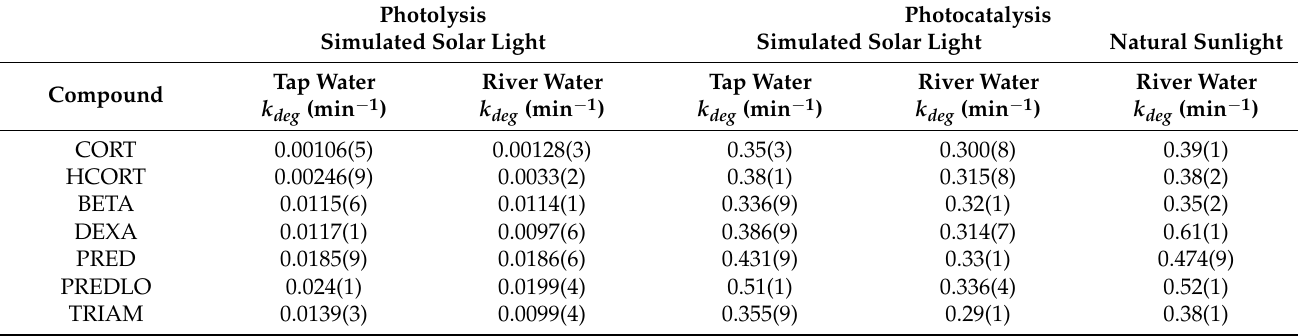
Table 2. Observed GCs degradation constants ( k deg ) (50 µ g L − 1 GCs, 0.5 g L − 1 TiO 2 , tap and river water, simulated, and natural